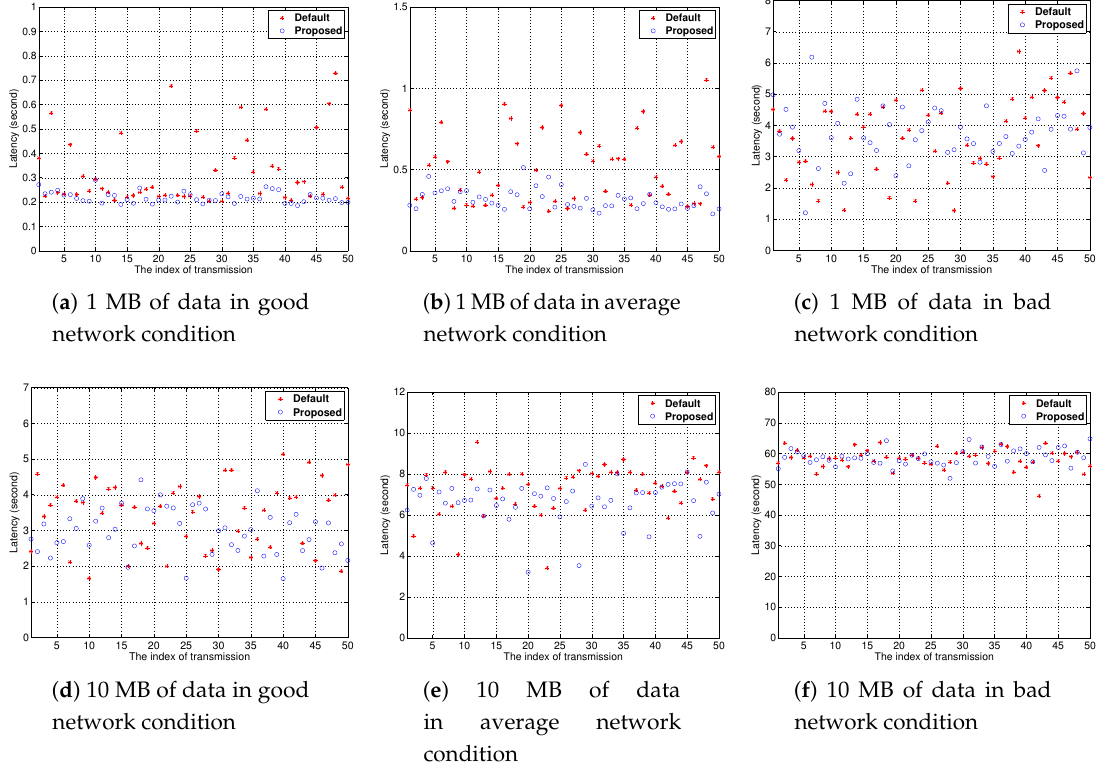
Figure 9. Transmission latency with simple topology ( a – c ) 1 MB of data and ( d – f ) 10 MB of data in ( a , d ) good, ( b , e ) average and ( c , f ) bad network